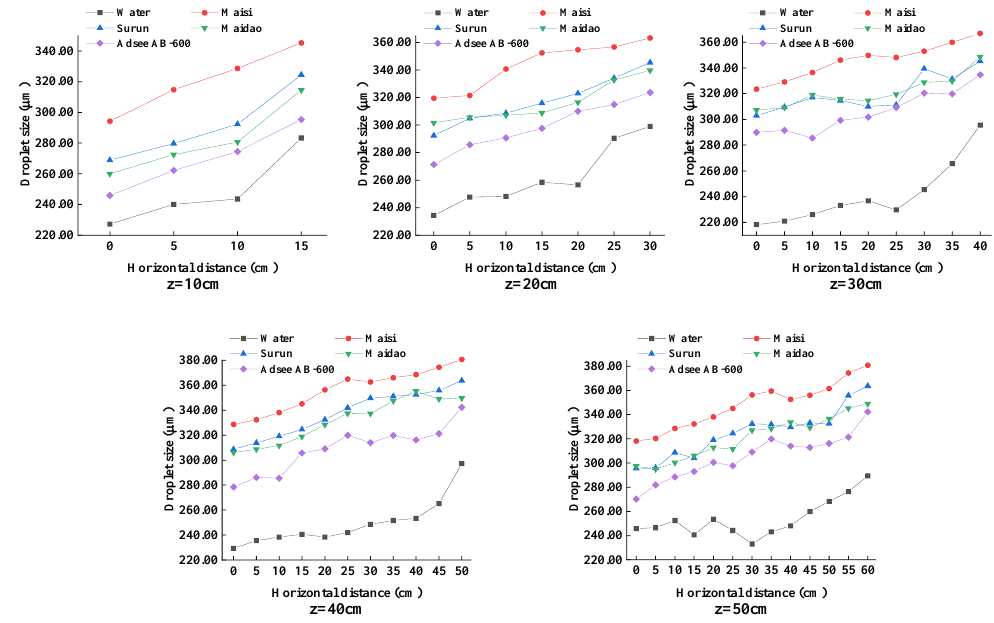
Figure 6. Horizontal direction droplet size D X distribution in different